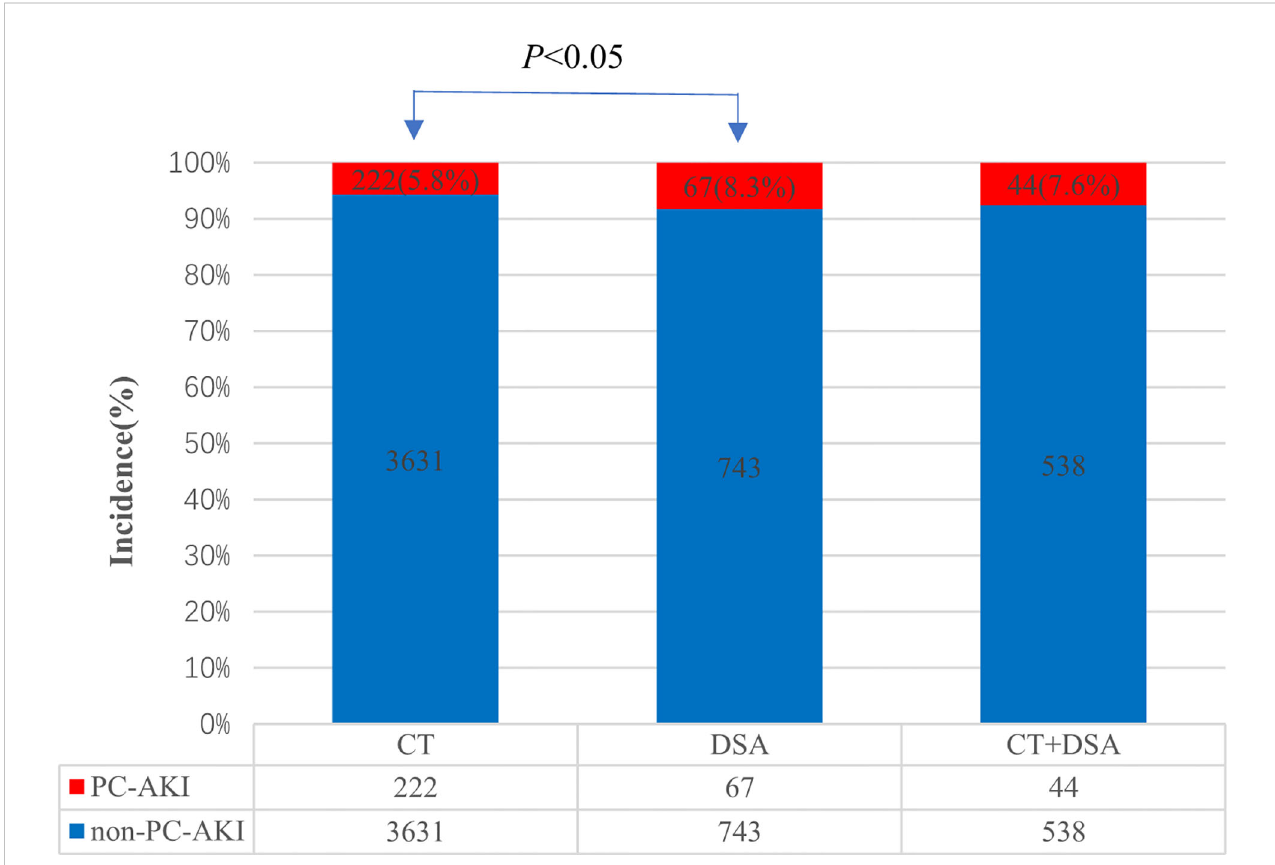
FIGURE 2 Incidence of PC-AKI in different examination methods.